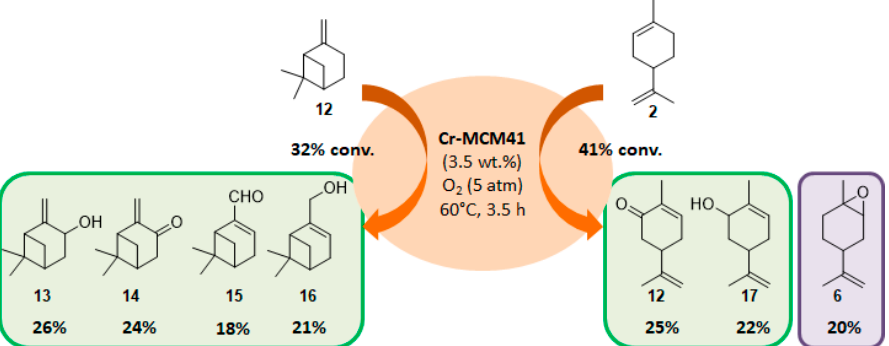
Figure 3. Solvent-free oxidation of terpenic olefins using Cr-MCM41 catalyst (adapted from reference [12]).